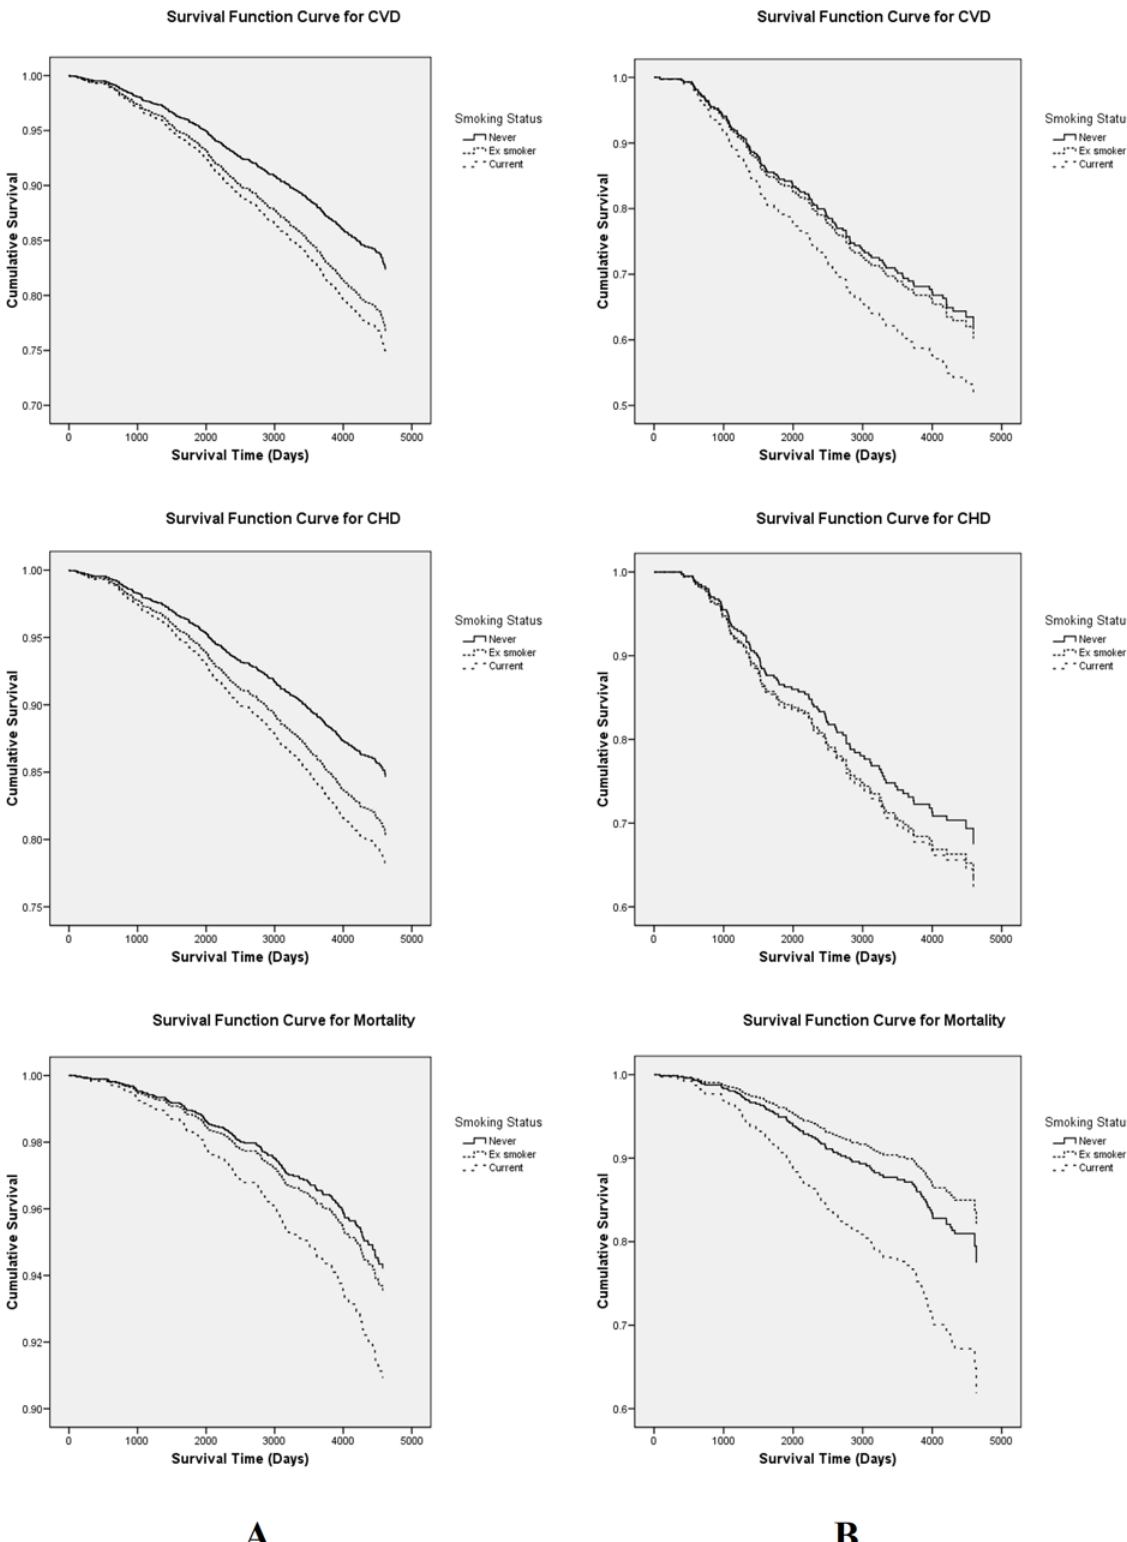
Fig 1. Kaplan – Meier Survival Function Plots of Different Smoking Categories for Incident CVD, CHD and Mortality. (A) Non-diabetic participants, (B) Type 2 Diabetes patients. CVD, cardiovascular disease; CHD, coronary heart disease. doi:10.1371/journal.pone.0149780.g001 PLOS ONE | DOI:10.1371/journal.pone.0149780 March 1,